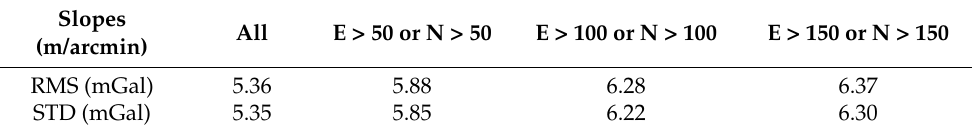
Table 3. Differences between SCSGA V1.0 and shipborne data since 1990 in shallow waters. Bathymetry